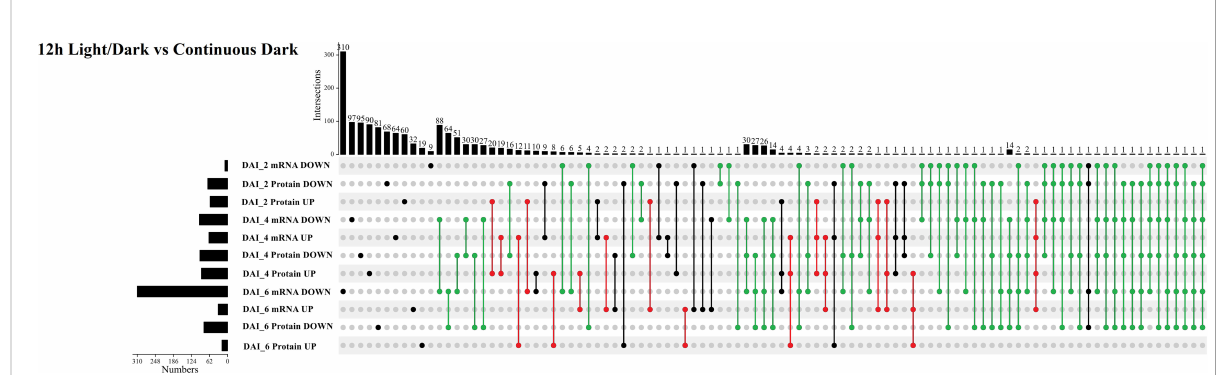
FIGURE 5 Multiple comparisons of light-regulated DEGs (DEPs) in seed germination and post-germination developmental stages. The histogram on the left represents the number of co-up and co-down regulated DEGs (DEPs) within each comparison. The histogram on the top represents the number of co-up or -down regulated DEGs (DEPs) from multiple comparisons. Multiple comparisons were displayed by lines and linked